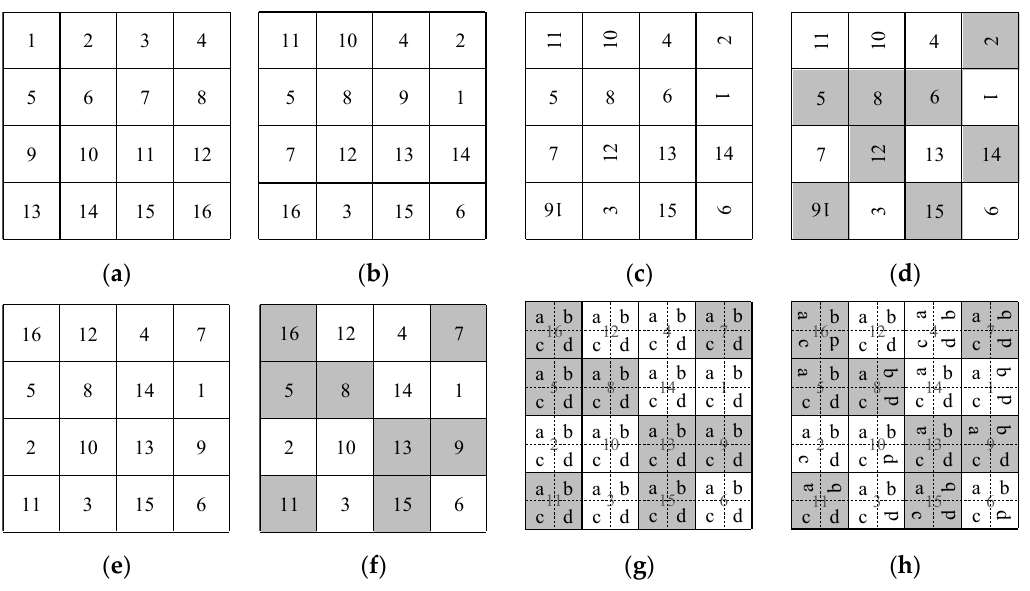
Figure 2. Comparison of conventional and proposed perceptual encryption algorithms. The encryption steps are illustrated in ( b – d ) for conventional methods and ( e – h ) for proposed method. ( a ) original blocks in the image. ( b , e ) are blocks permutation steps. ( c ) is blocks rotation and inversion step. ( d , f ) are negative and positive transformation steps where shaded blocks are the transformed ones. ( g ) is division of blocks into sub-blocks shown by dashed vertical and horizontal lines. ( h ) is sub-blocks rotation and inversion step.